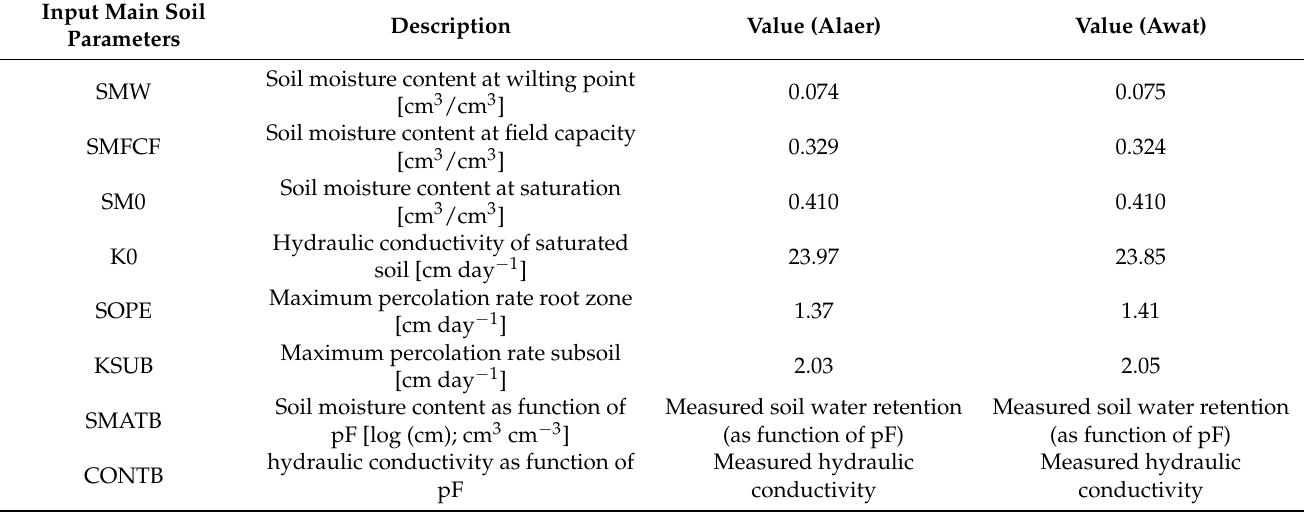
Table A1. Input main soil parameters for two